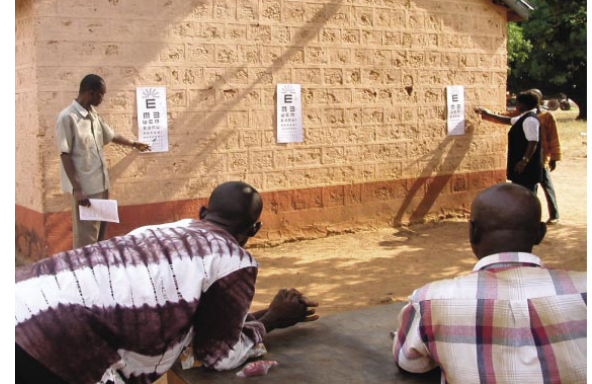
Figure 9 . Coordinators measuring Adspec refractions outdoors.